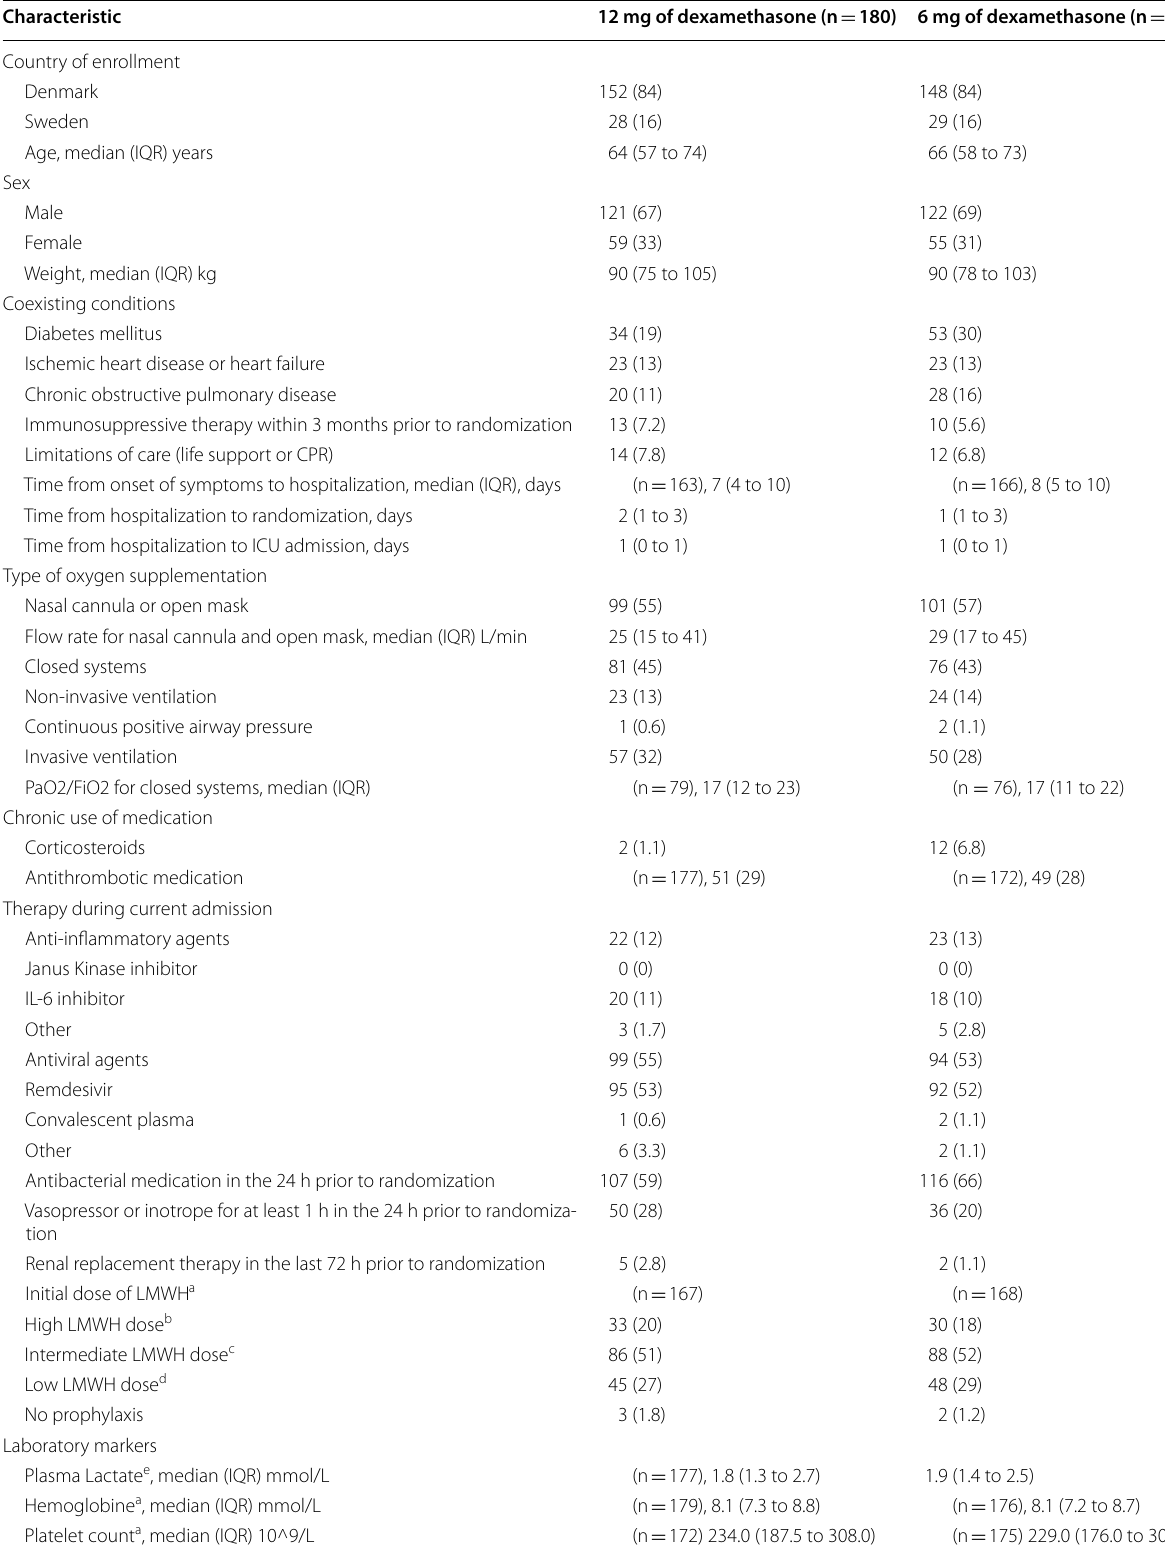
Table 1 Baseline characteristics by dose of dexamethasone